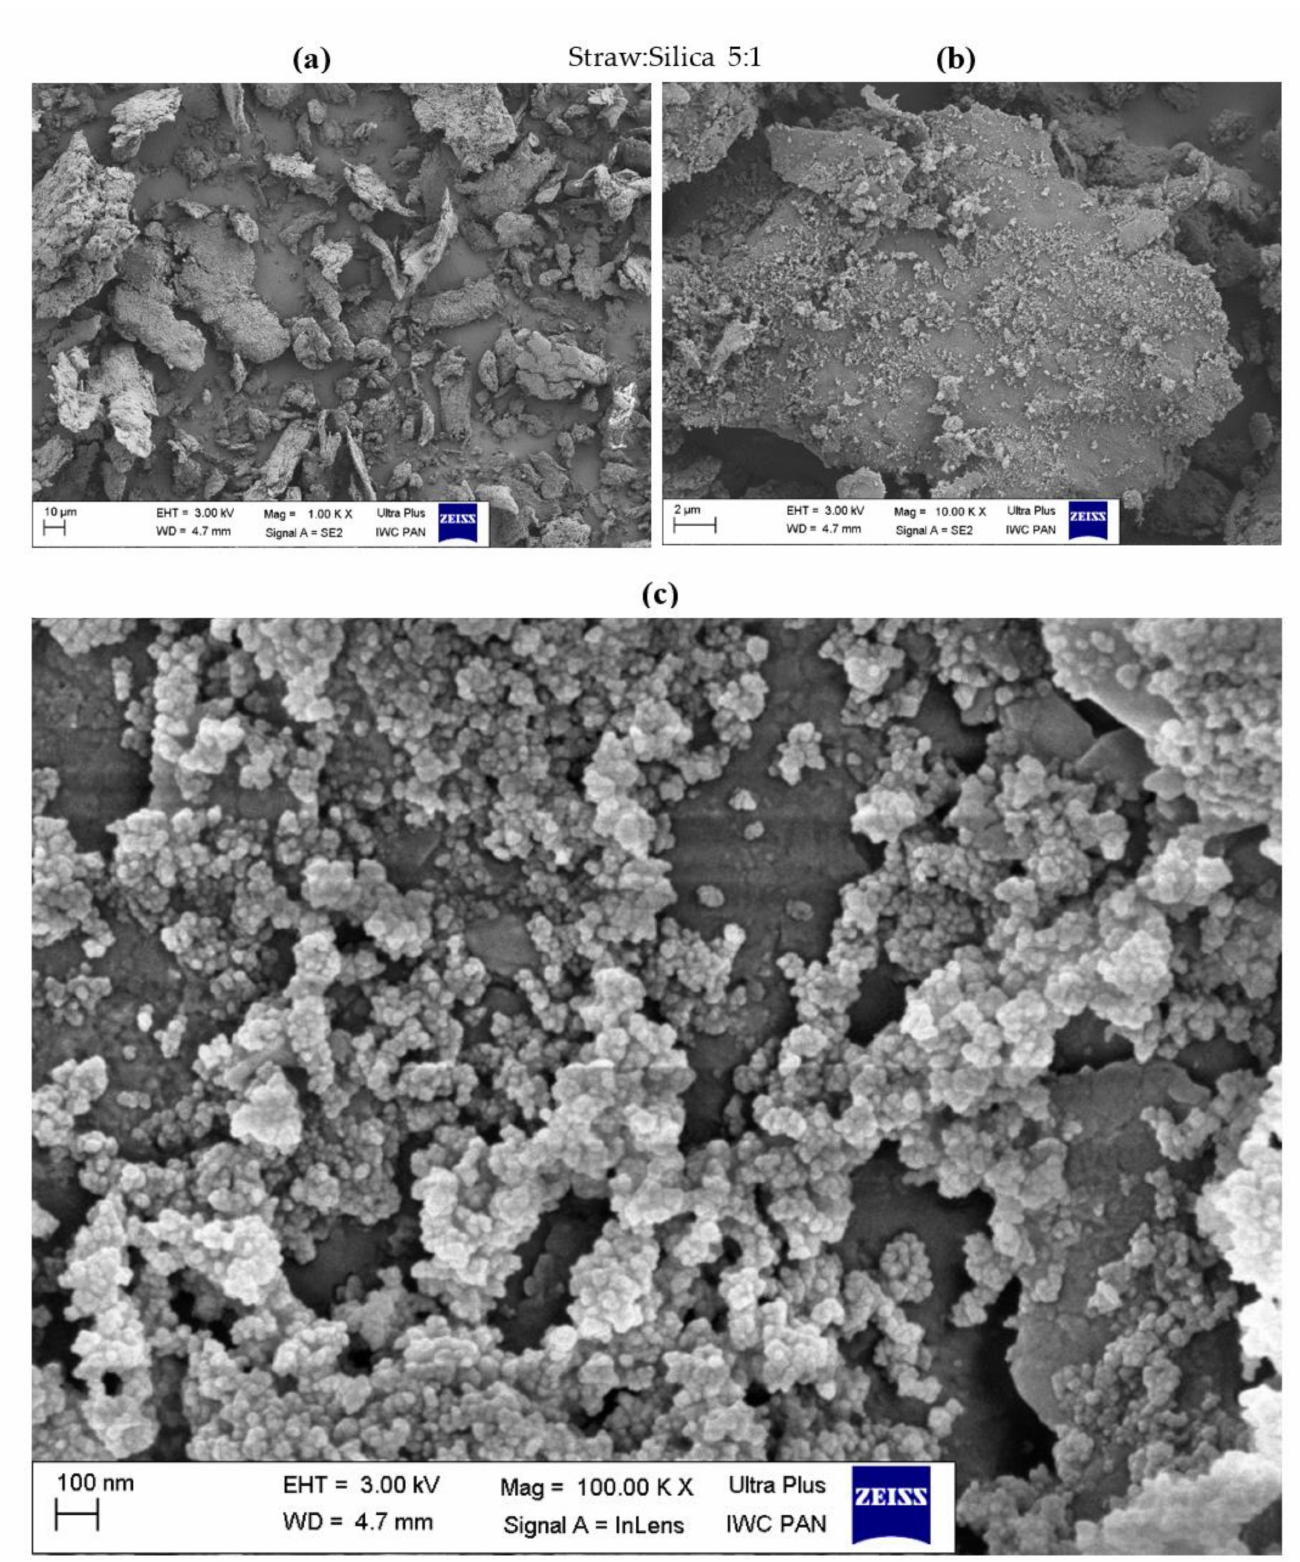
Figure 7. Microscopic images of straw fillers with the addition of silica (5:1) at a magnification of ( a ) × 1.00 k, ( b ) × 10.000 k, ( c ) × 100.00